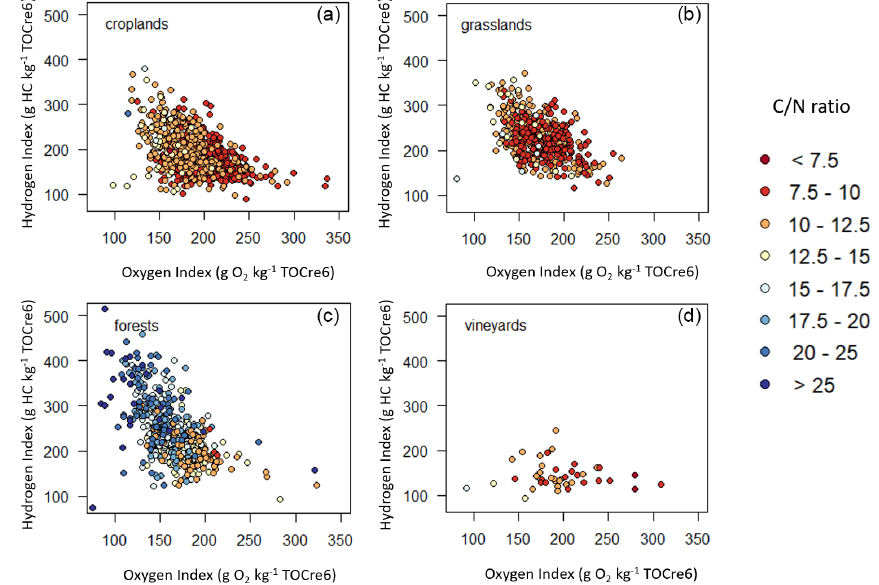
Figure 3. Rock-Eval ® pseudo van Krevelen diagrams (hydrogen index = f (oxygen index)) for the RMQS topsoil (0–30cm) samples in (a) croplands, (b) grasslands, (c) forests, and (d) vineyards and orchards. Colours indicate the values of the C / N ratio. Samples are limited to those with Rock-Eval ® organic carbon yields ranging from 0.7 to